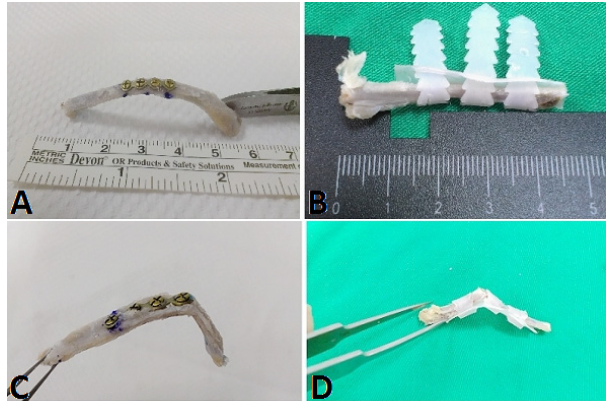
Figure 2. The rib fracture model fixed by ( A ) titanium miniplate and ( B ) PCL fixator. During the three-point bending biomechanical study, ( C ) a new fracture was observed at the edge of the miniplate in the Ti group and ( D ) the locked mechanism remained intact in the PCL fixator group.